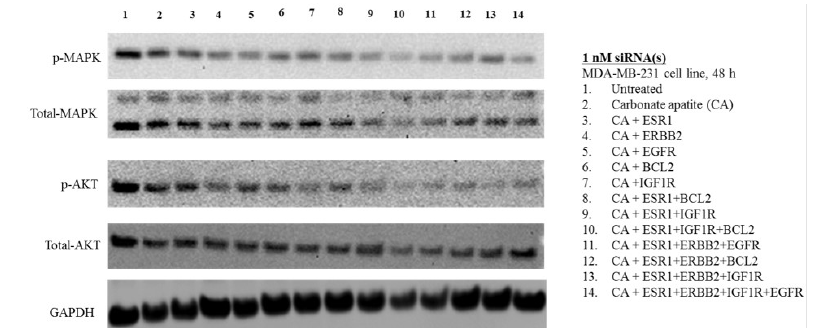
Figure 8. Effects of intracellular delivery of various CA ‐ siRNA complexes on expression and activation of AKT and MAPK proteins in MDA ‐ MB ‐ 231 cell line. Preparation of the CA ‐ siRNA(s) complexes involved introduction of ESR1, ERBB2, IGF1R, EGFR and BCL2 siRNAs individually or in combination with 3.5 mM of CaCl 2 to 1 mL of bicarbonate ‐ buffered DMEM (pH 7.4). The mixture was allowed incubation at 37 °C for 30 min before the addition of 10% FBS. The cells were incubated for a consecutive period of 48 h with the prepared complexes, prior to cell lysis for protein extraction and Western blot analysis. Proteins were loaded on SDS ‐ PAGE and transferred onto nitrocellulose membrane for detection of p ‐ MAPK, p ‐ AKT, total MAPK, total AKT and GAPDH (housekeeping protein) expressions.